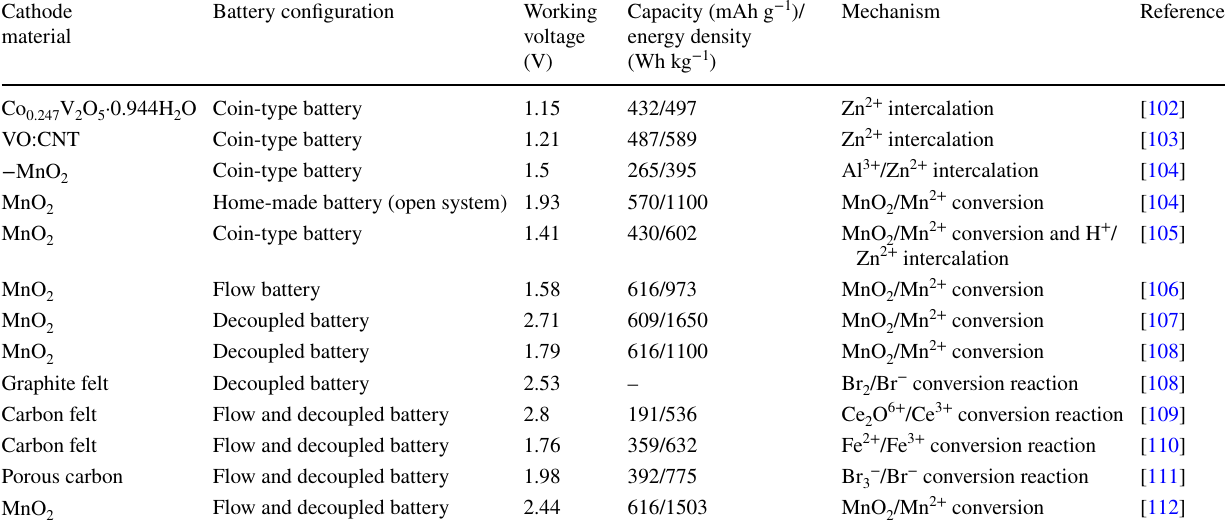
Table 2 The performance of high-capacity, high-voltage aqueous Zn batteries [101]. Copyright 2022, Wiley–VCH Cathode